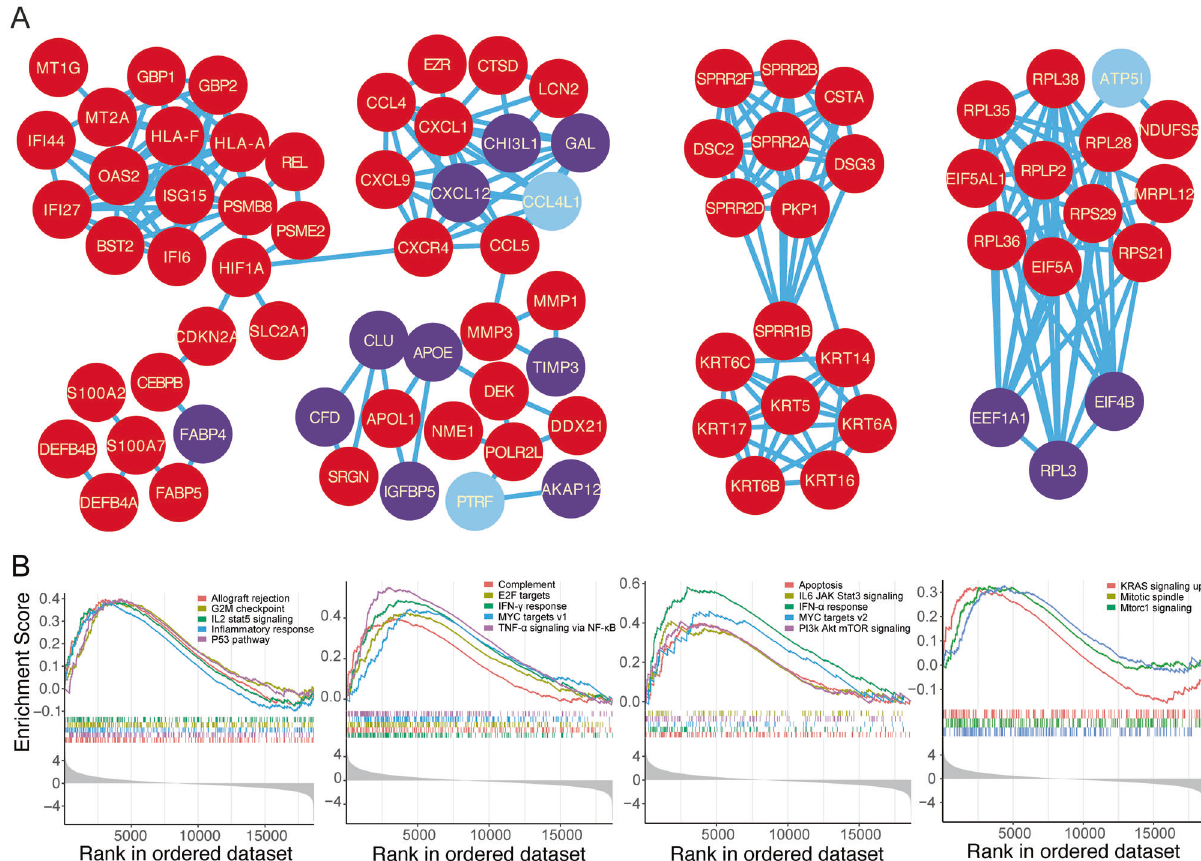
Fig. 3 PPI network and GSEA analysis. A PPI network analysis shows the interactions among the DEGs. B Many cancer-related pathways were upregulated in cSCCs by